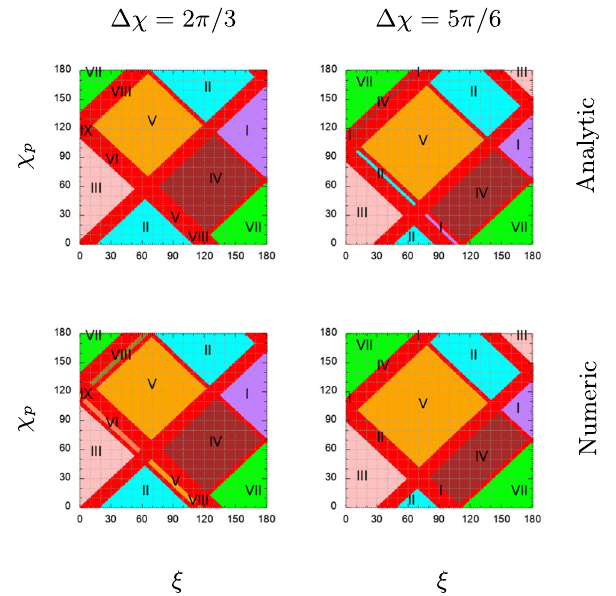
Fig. 20 Classlocationmapsonthe ξ − χ p plane.Schwarzschildmetric, (cid:11) = 0 . 3